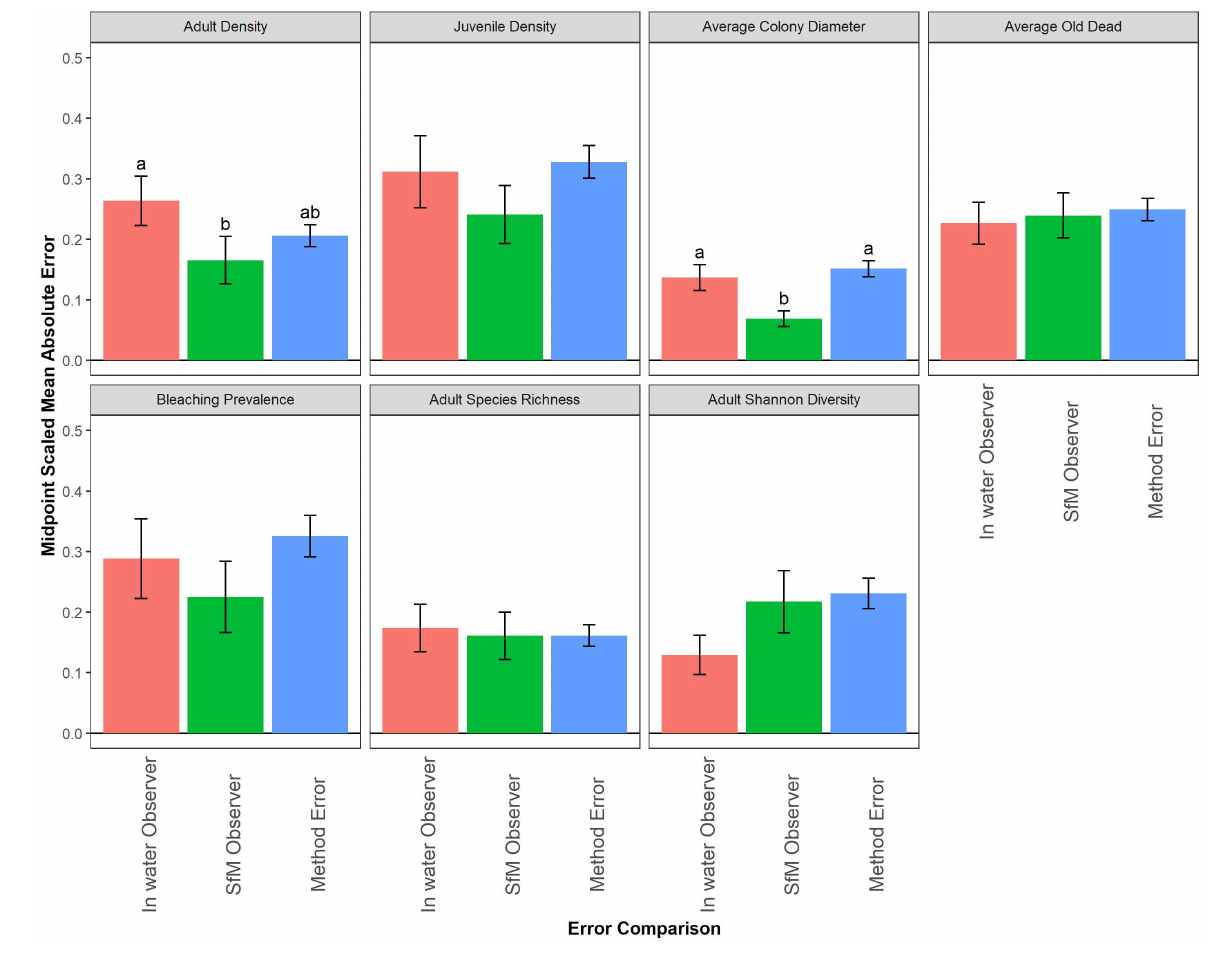
Frontiers in Marine Science |